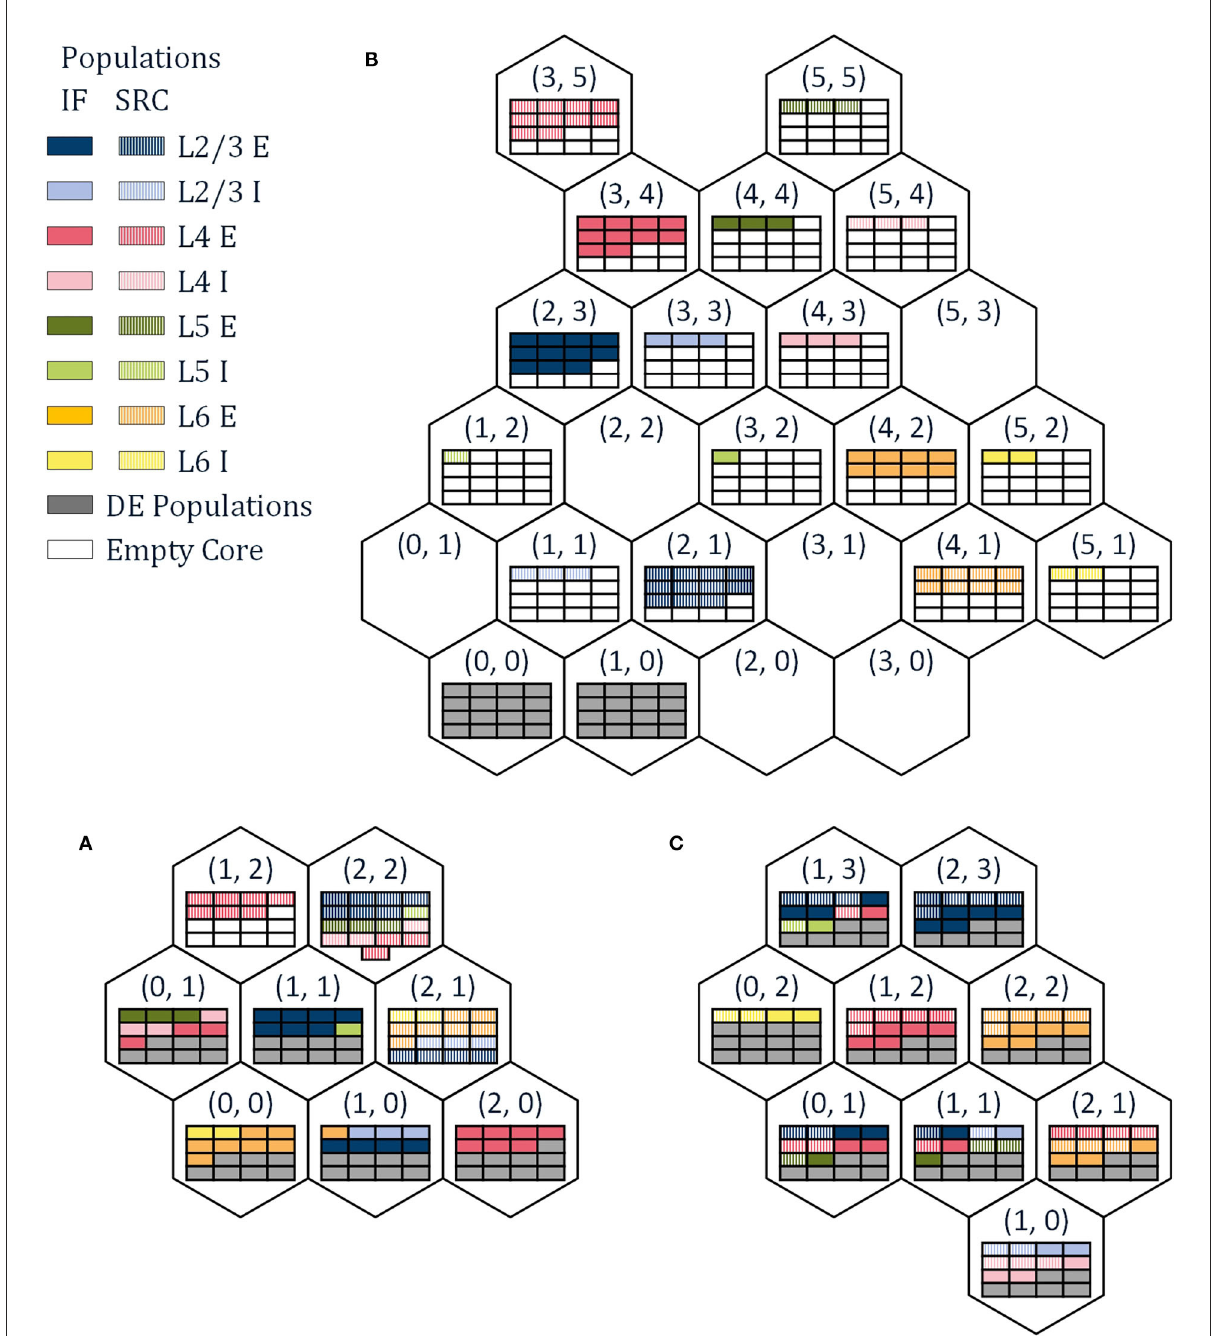
FIGURE2 The resulting neuron maps for the three different mapping approaches used in this work, (A) PArtition and Configuration MANager (PACMAN), (B) MANUAL, and (C) GHOST.